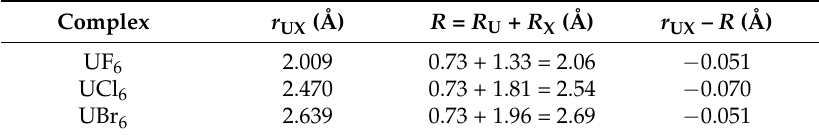
Table 4. B3LYP-calculated structural parameters UX 6 . R = 6-coordinated Shannon ionic